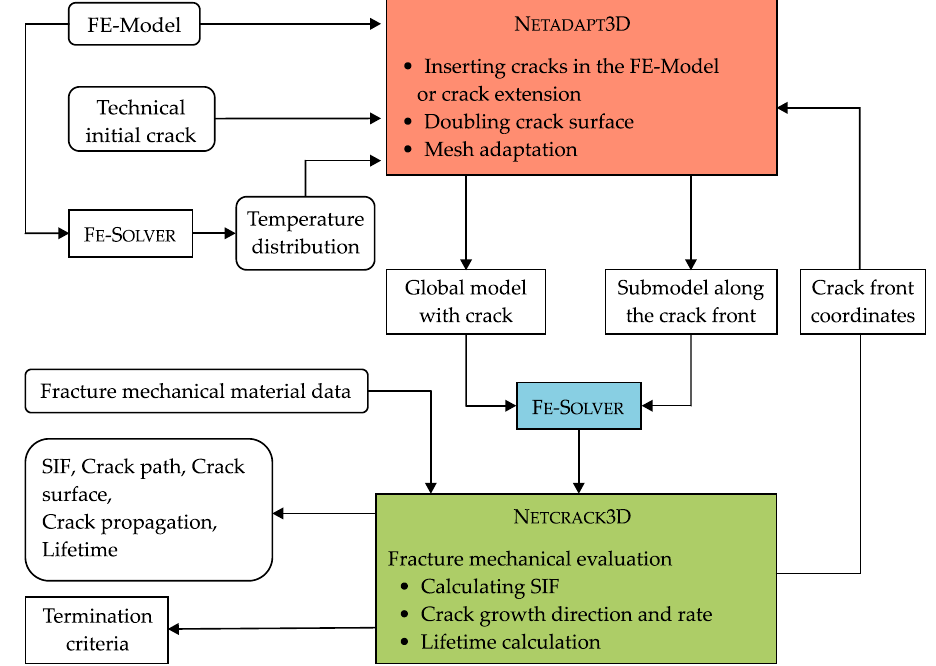
Figure 1. Structure of the crack growth simulation program Adapcrack3D.